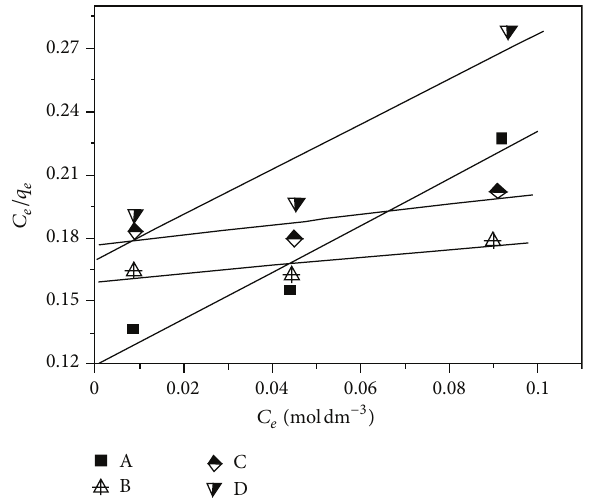
Figure 2: Plot of the Langmuir isotherm model for lead(II) adsorp- tion on samples A–D.